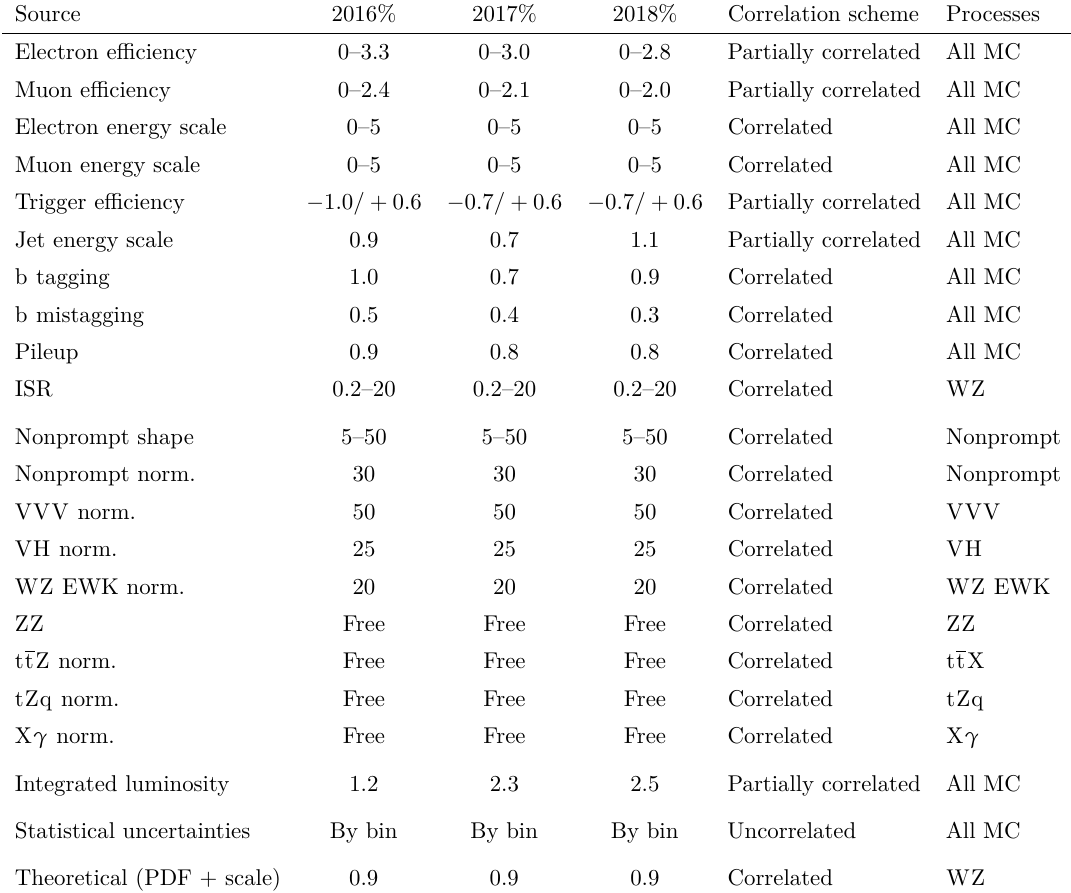
Table 2 . Summary of the uncertainties in the analysis, their relative effect for each of the data- taking years, the correlation scheme followed, and which processes are affected by them. Uncer- tainties related to experimental measurements of efficiencies and energy scales are presented as percentages of the predicted signal yield. Uncertainties related to normalization of specific back- ground processes are described as percentages of the yield of each process or as free if the process is freely floating in the fits. Lepton-related uncertainties are shown as a range as most measurements of the analysis are split in flavour channels, with which the size of these uncertainties is strongly correlated. Systematic uncertainties with an asymmetric effect are marked with a / separating the upwards and downwards